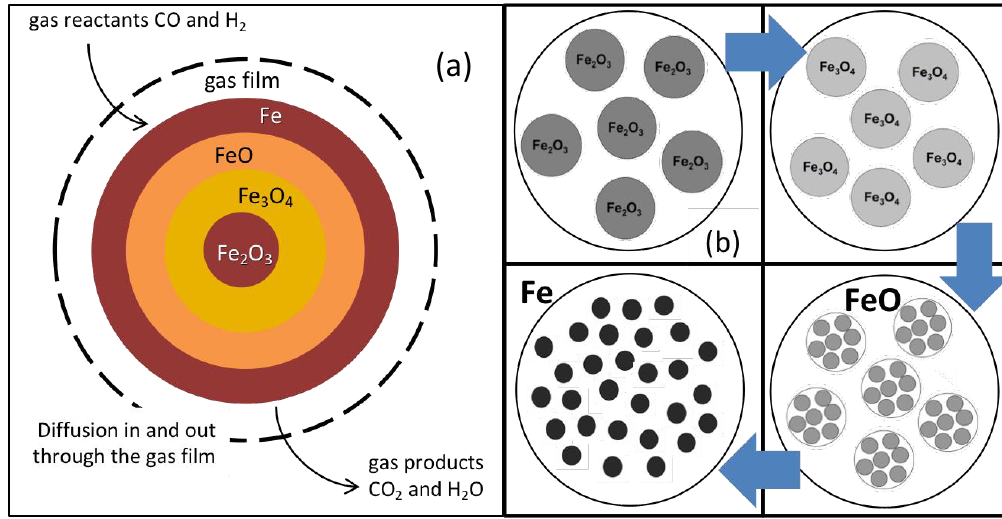
Figure 1. Evolution of pellet structure along with reaction: ( a ) Unreacted Shrinking Core Model; ( b ) Grain Model. The porous structure evolution ( b ) was determined from experimental observations [7].